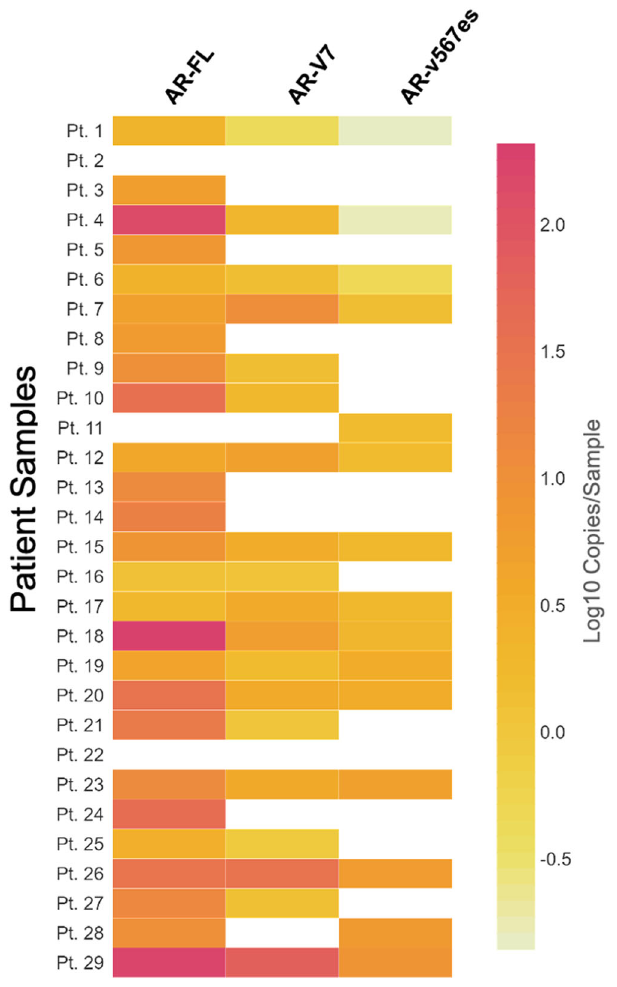
Fig. 1 Expression of AR-FL, AR-V7, and AR-v567es in CTCs from patients with mCRPC. CTCs were enriched from 29 patients with mCRPC by CD45 negative depletion and processed for quanti fi cation of each AR transcript by ddPCR. Heatmap of AR-FL, AR-V7, and AR-v567es expression per patient (not detected; white).